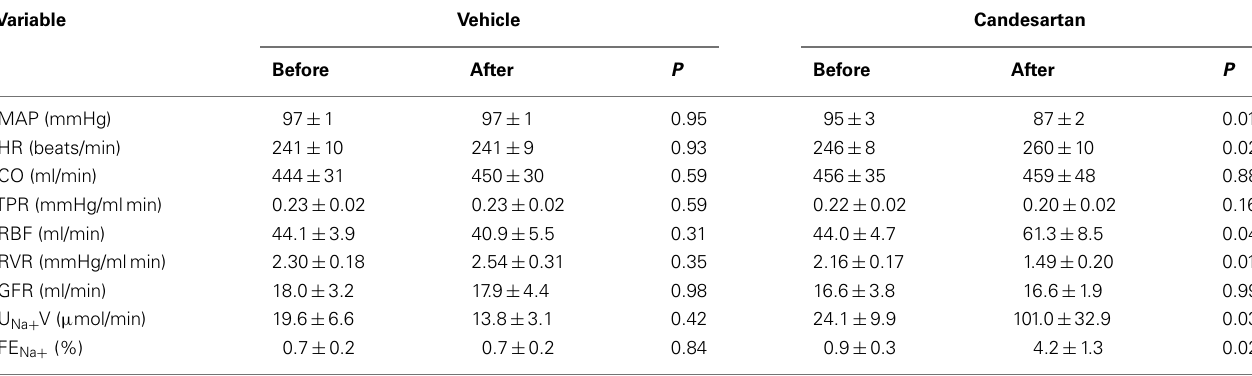
Table 1 | Responses of hemodynamic, and renal function variables to candesartan, and its vehicle. Variable Vehicle Candesartan